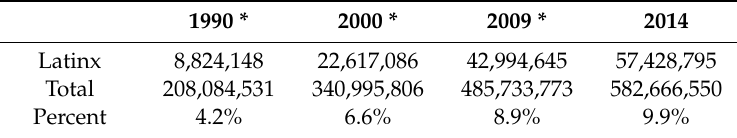
Table 5. Buying Power in Illinois for 1990, 2000, 2009, and